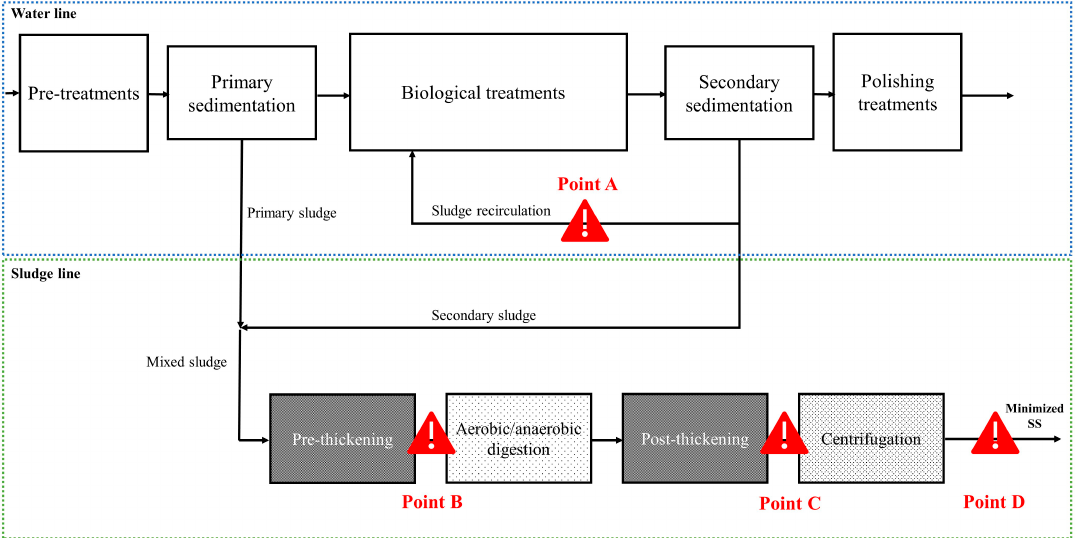
Figure 3. Points of possible application of advanced treatments in a conventional WWTP, in order to minimize the production of SS, in the water line (Point A) and in the sludge line: before hypothetical stabilization (Point B), before hypothetical centrifugation (Point C) and at the end of the line (Point D).